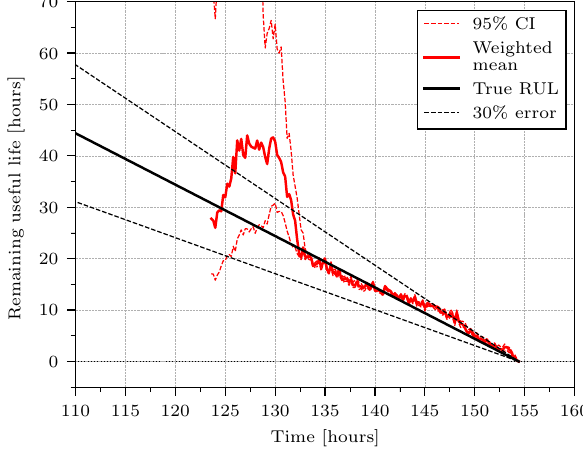
Figure 10: Estimated RUL of the in-house test rig dataset using the proposed method. The weighted mean, 95% CI, true RUL and 30% error margins are